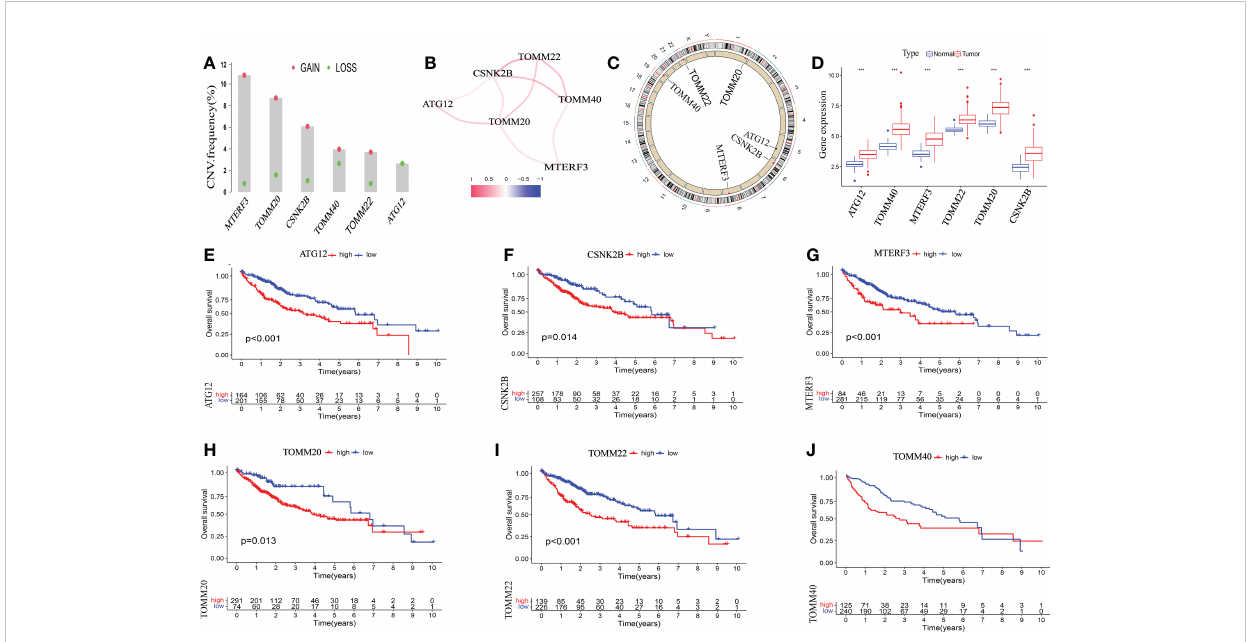
FIGURE 2 The genetic alterations of six mitophagy genes landscape in HCC. (A) The CNV alteration location of six mitophagy genes on chromosomes. (B) The CNV mutation frequency of six mitophagy genes was prevalent. The column represented the alteration frequency. The deletion frequency is red dot; The ampli fi cation frequency is blue dot. (C) The correlation among six mitophagy genes. (D) The differential expression levels in six mitophagy genes between normal and tumor samples. The asterisks represented the statistical P-value (***P < 0.001). (E-J) Kaplan – Meier analysis of six mitophagy genes between low and high